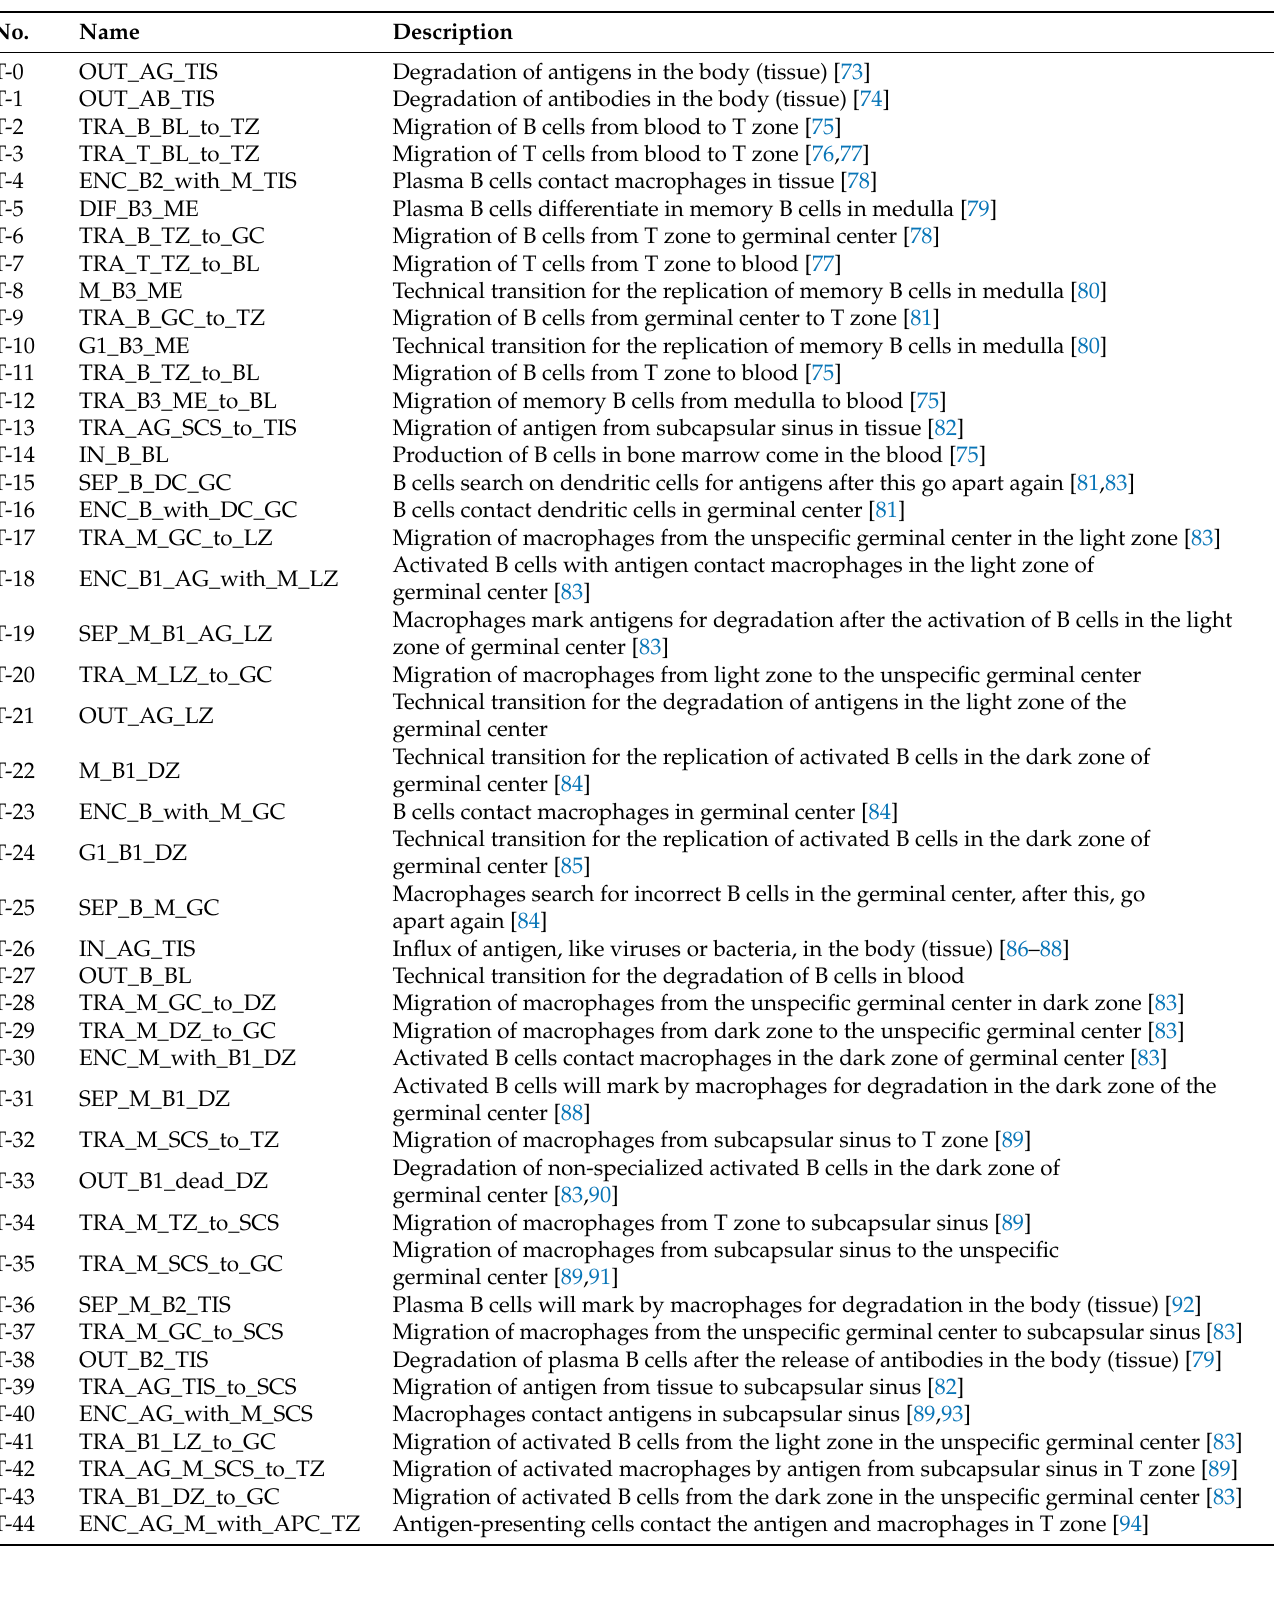
Table A2. List of 65 transitions, their names, and a description of their biological representatives. The prefix of the name encodes the reactions and processes. The abbreviations are explained in Table 3. In the middle are the interacting cells in the abbreviation from Table 2. The suffixes of the names encode the compartment in which the species is located; for the abbreviations of the compartments, refer to Table